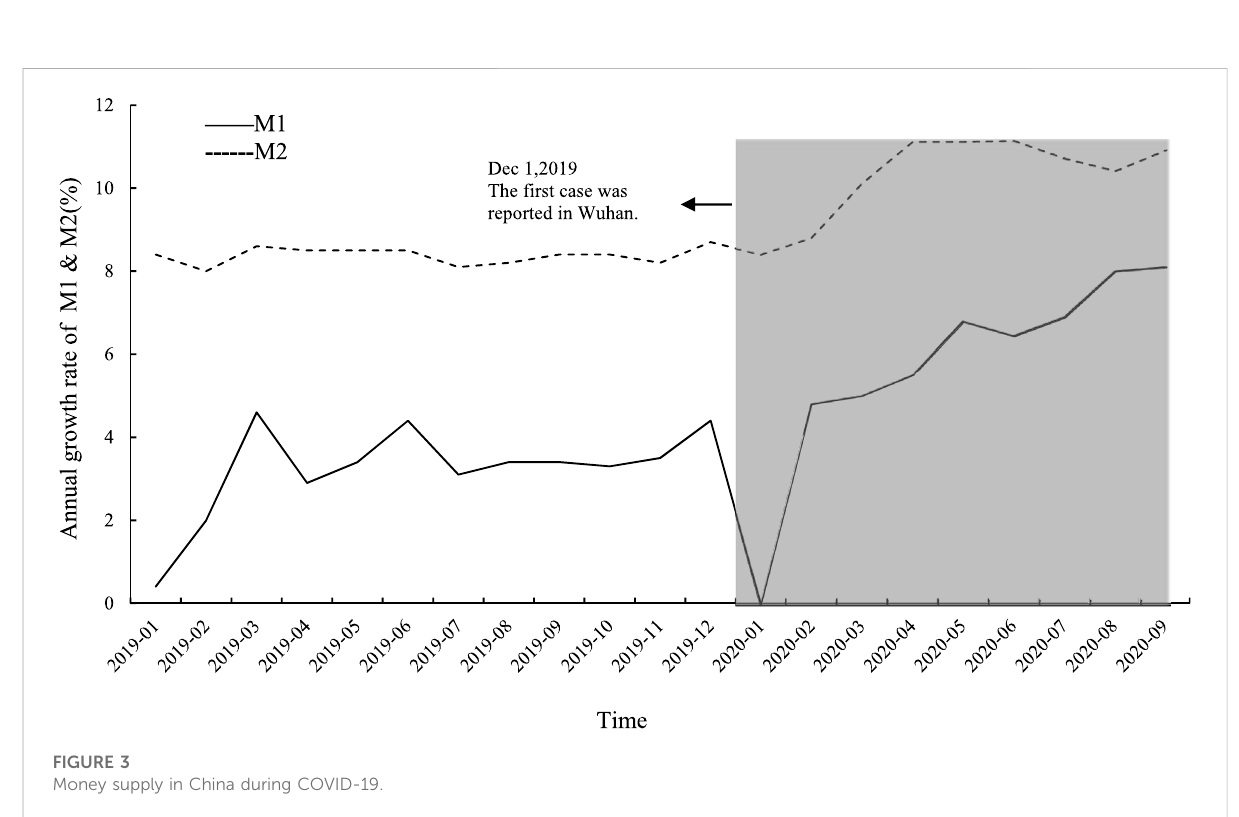
FIGURE 3 Money supply in China during